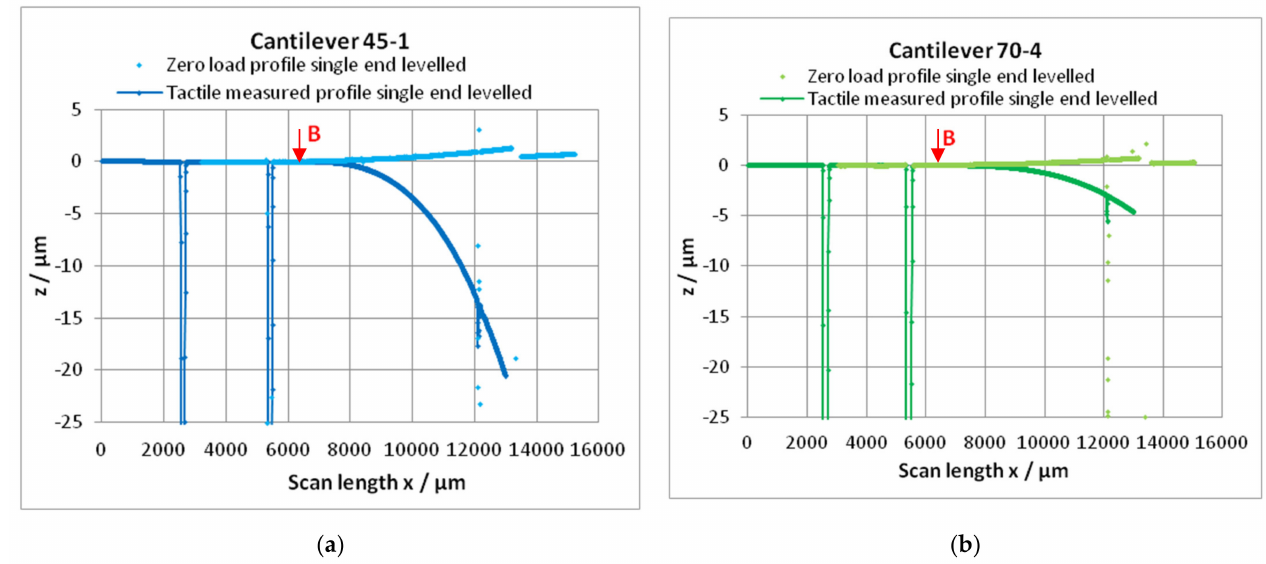
Figure 9. Tactile measured profile (dark) and the zero-load profile (bright, measured with autofocus sensor) ( a ) of the cantilever chip 45-1 (nominal thickness 45 µ m) and ( b ) of the cantilever chip 70-4 (nominal thickness 70 µ m). B : beginning of the